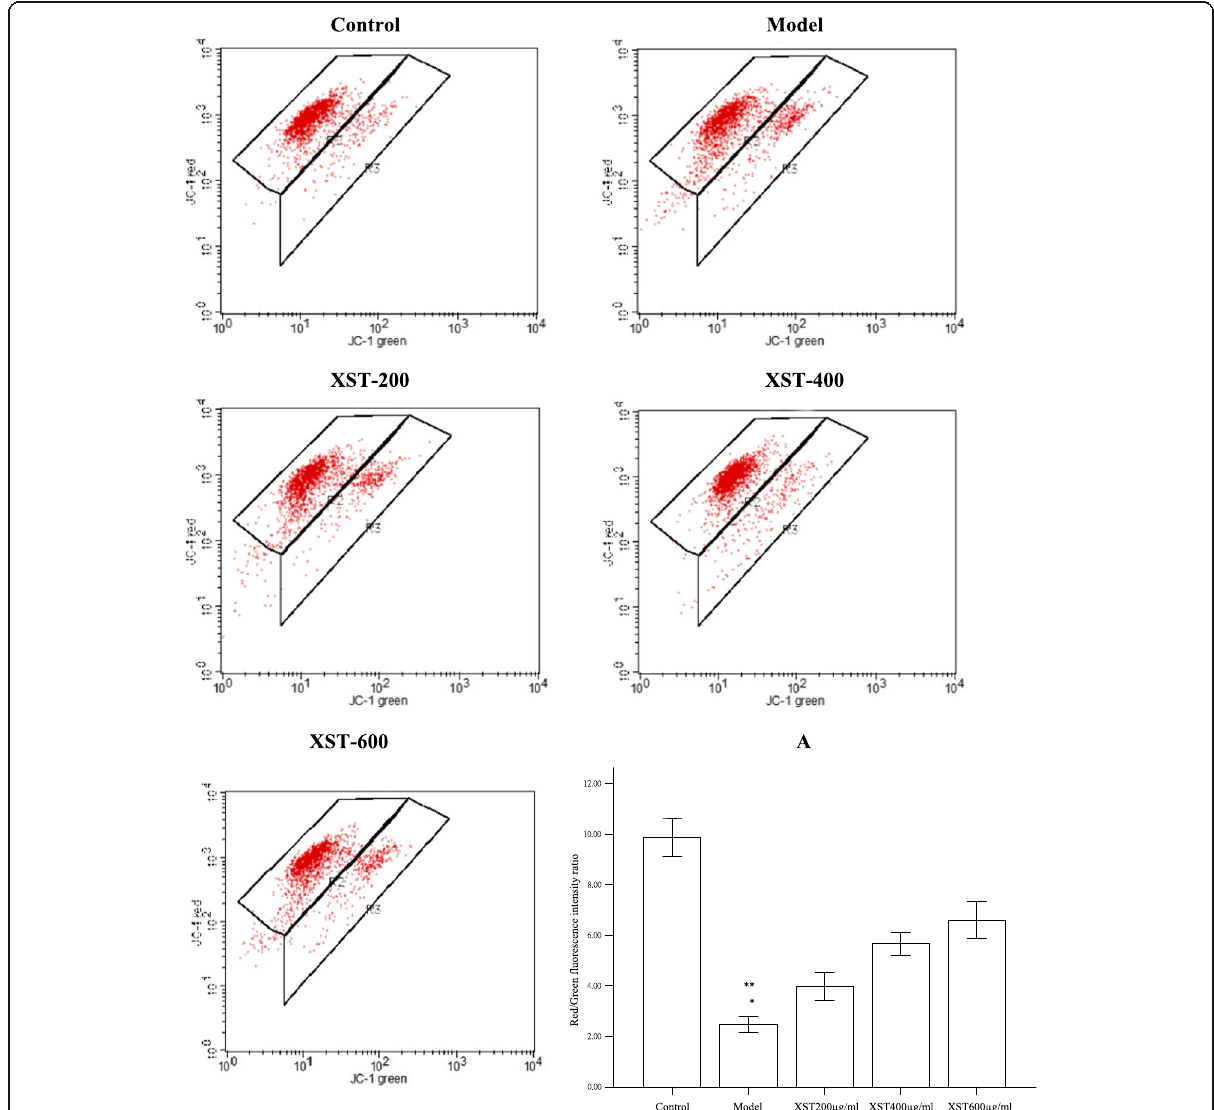
Fig. 2 The cell suspensions were analyzed and sorted with flow cytometry according to the different intensity of red and green fluorescence in the five groups. X and Y axes indicated the logarithm of the relative intensity of green and red fluorescence, respectively. Bar graphs. a showed the quantitative assessment of the red/green fluorescence intensity ratio. All samples were checked in three independent experiments with three replicates each. Data are represented as the mean ± SD ( * P <0.05 vs. XST 400 and 600 μ g/ml, ** P <0.001 vs. the control